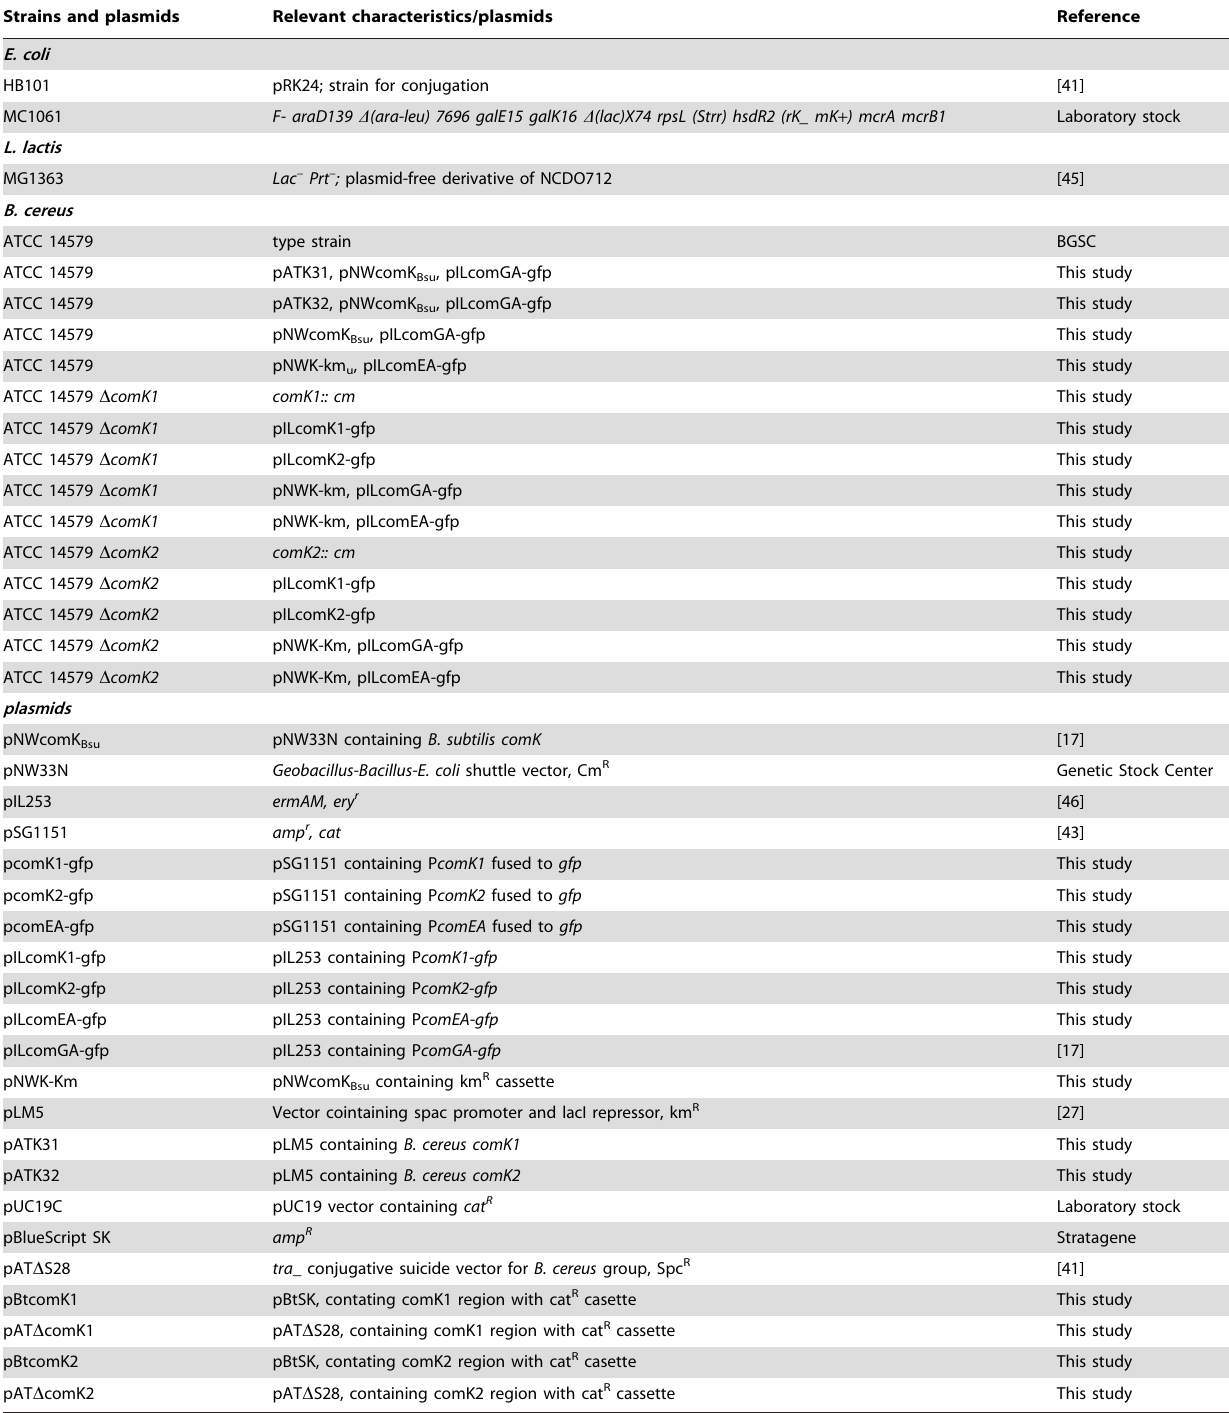
Table 3. Strains and plasmids used in the